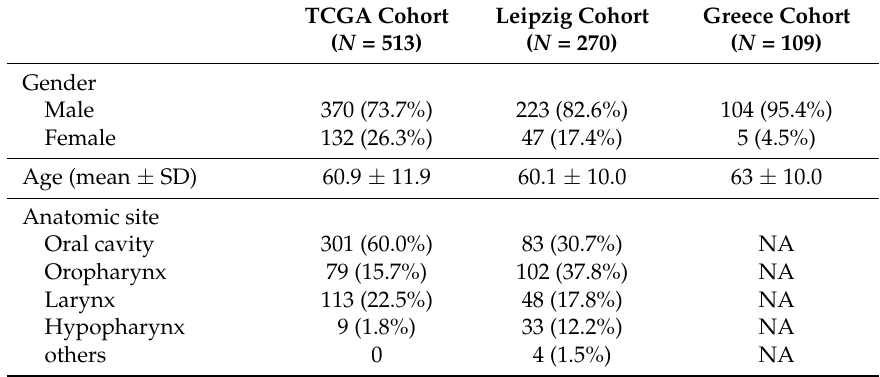
Table 1. Patient demographics and clinical characteristics of the three independent